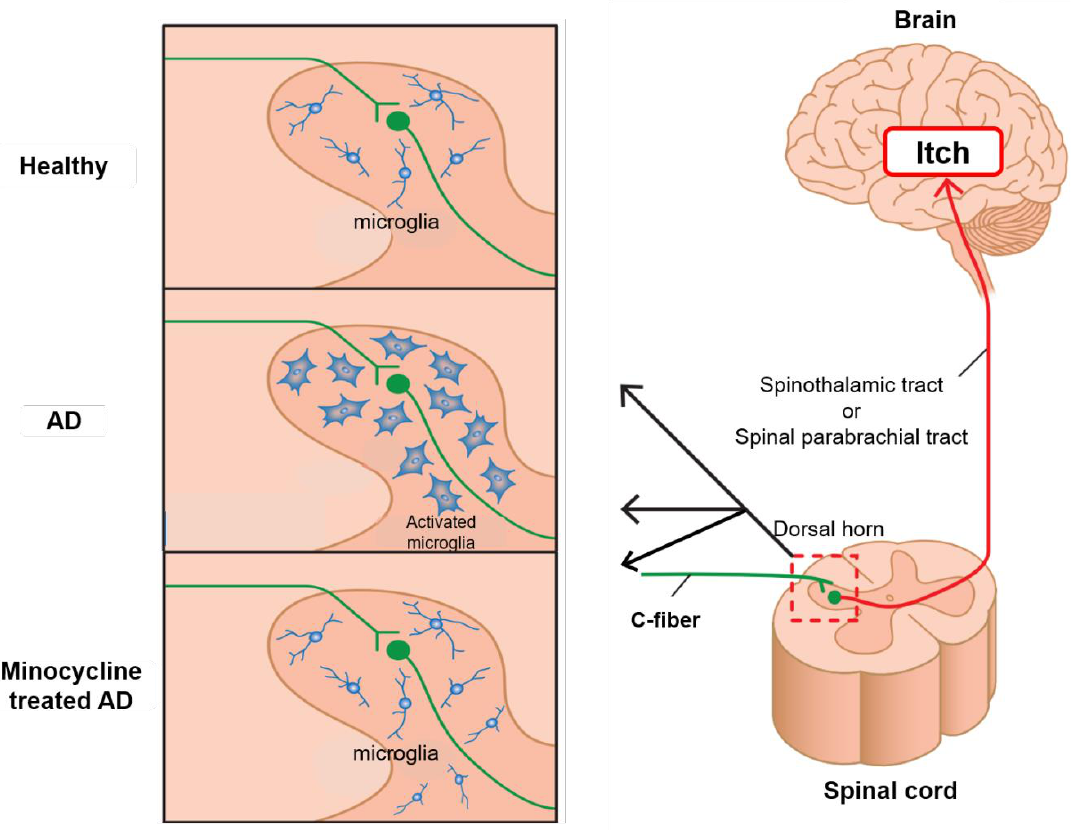
Figure 3. Antipruritic mechanism of minocycline in AD. The number of microglia is increased in the dorsal horn of the spinal cord of mice with AD. The administration of minocycline decreases the number of microglia in the spinal dorsal horn and suppresses itch and dermatitis.